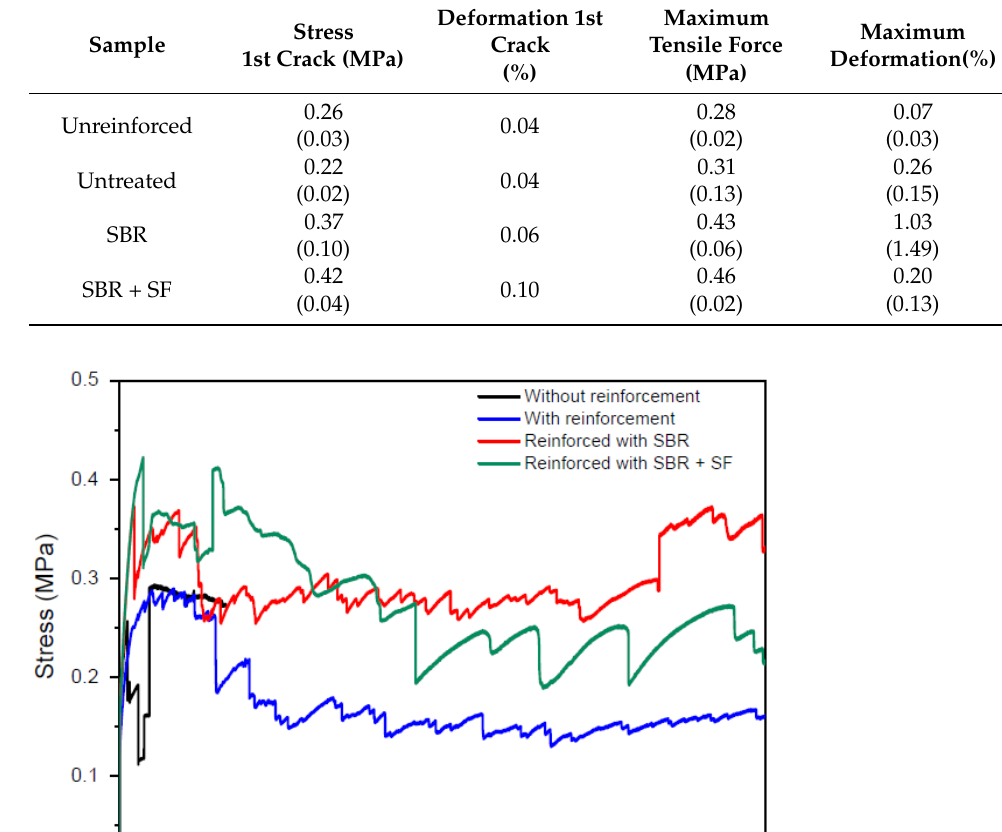
Table 3. Results of the direct tensile testing of the composite (values in the parentheses correspond to the standard deviation).